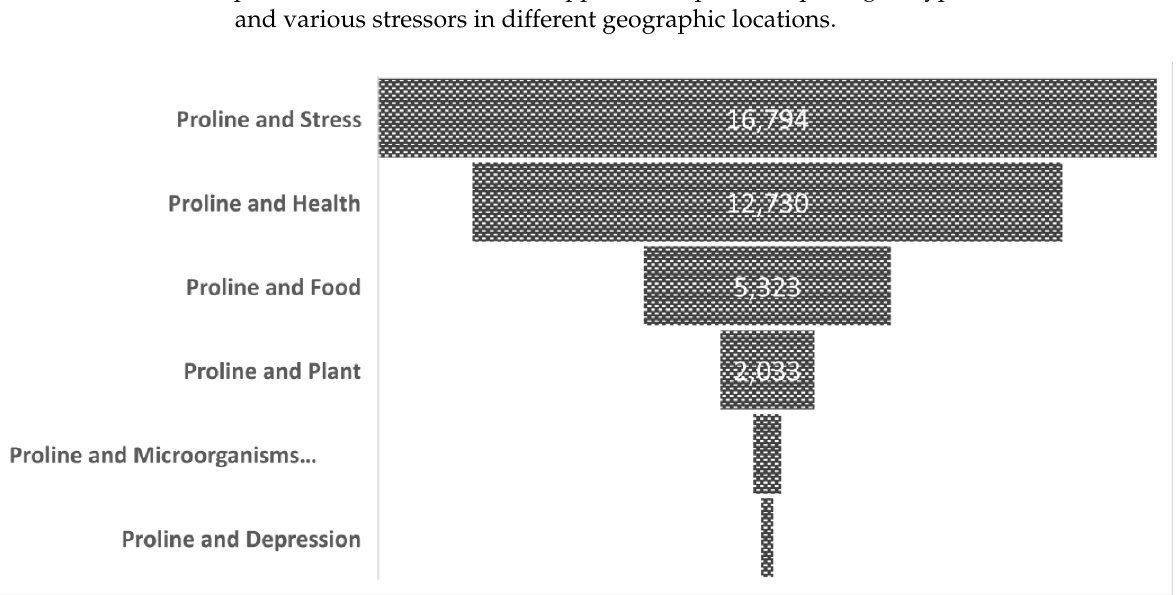
Figure 3. Web of Science data depicting published (1900–2022) articles on proline related to major scientific domains (data retrieved on 15 July